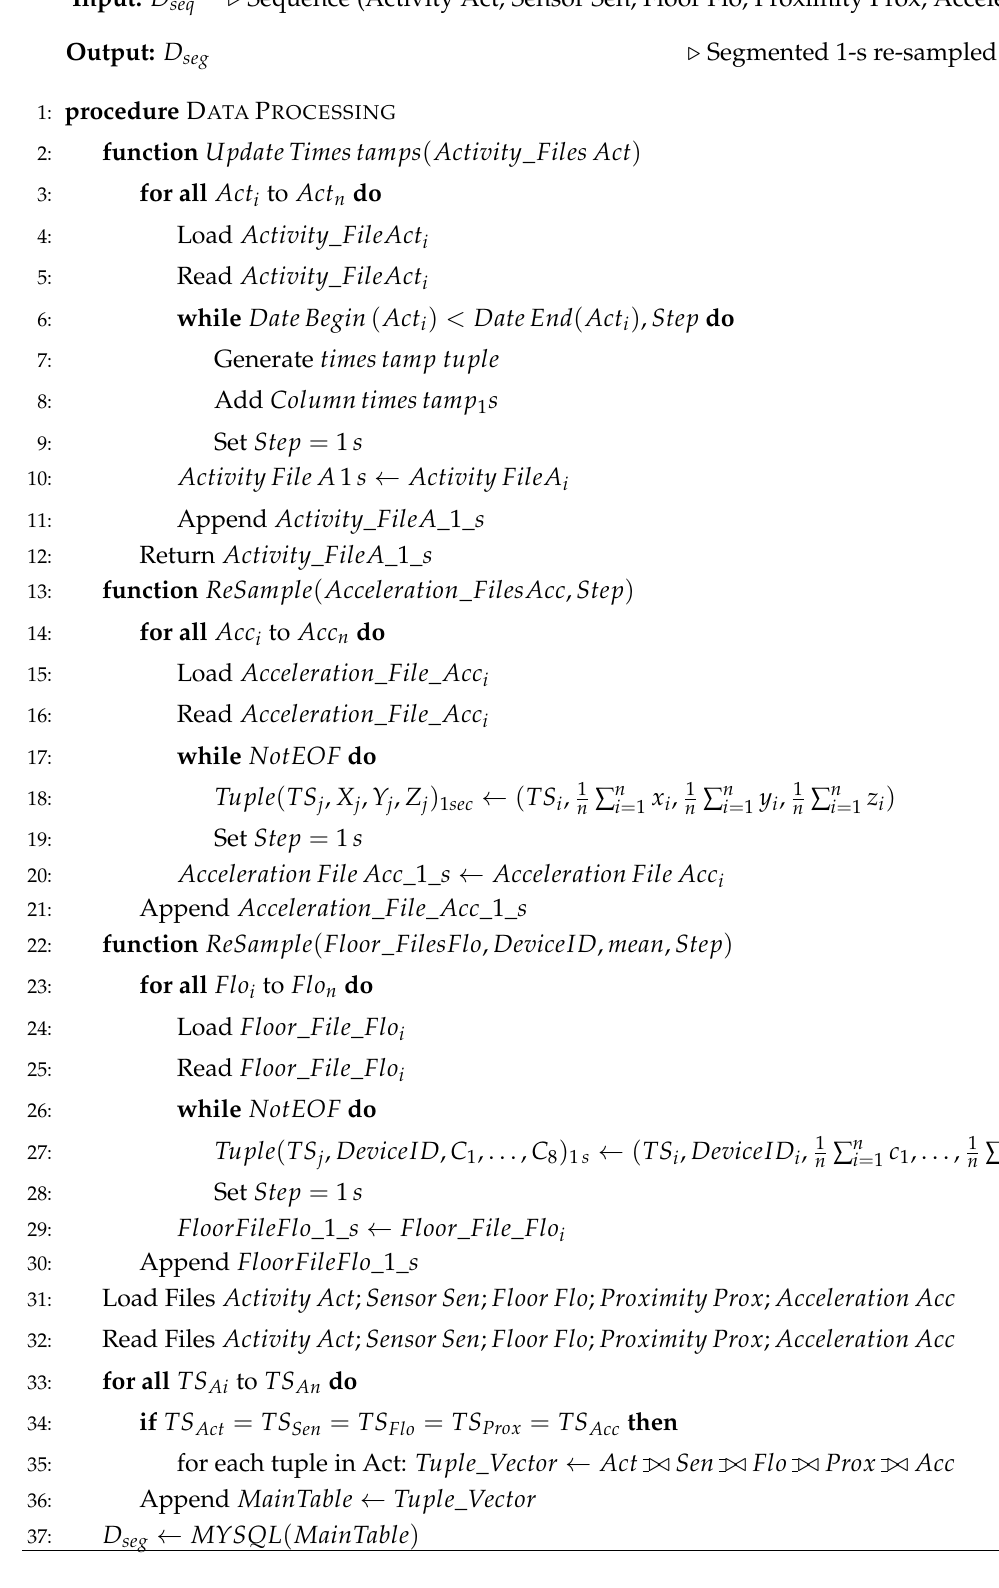
Algorithm 1 Data alignment and re-sampling algorithm for UJAmI Smart Lab dataset ( D